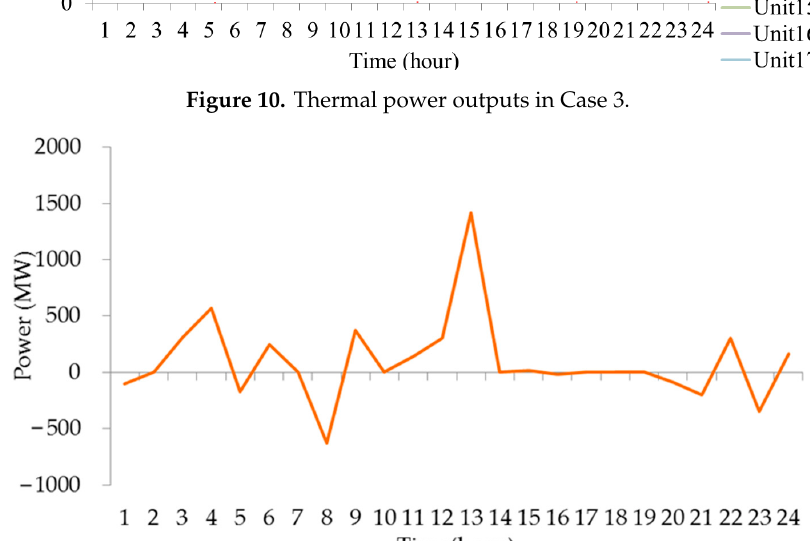
Figure 11. Pumped storage power outputs in Case 3.